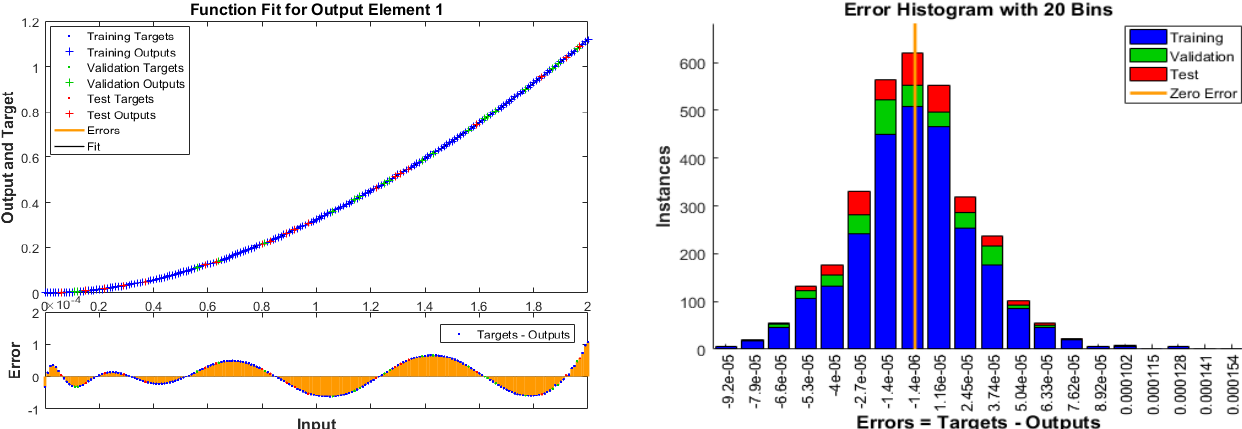
Upshots of fitness and E.H. of Scenario 1 Figure 7. Cont